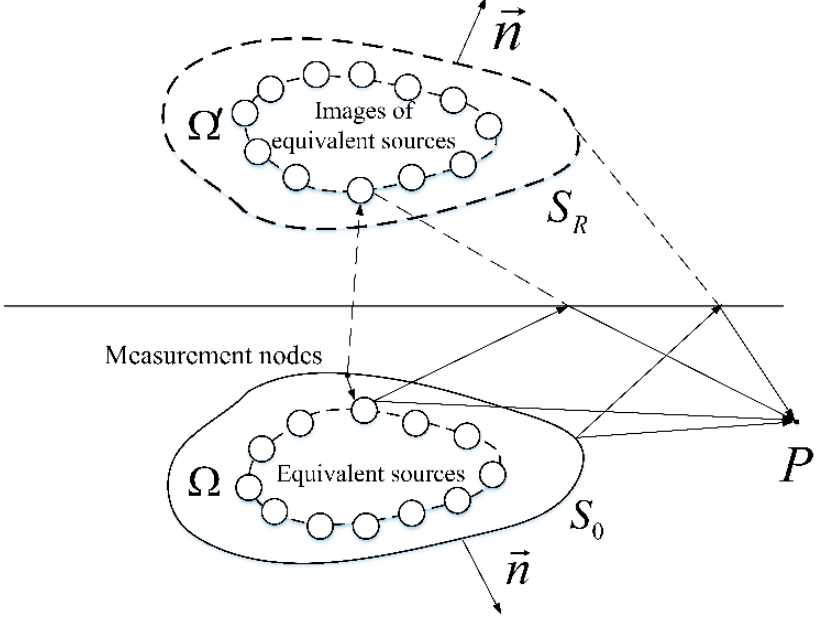
Figure 2 . The schematic diagram of the equivalent source method in half-space. Figure 2. The schematic diagram of the equivalent source method in